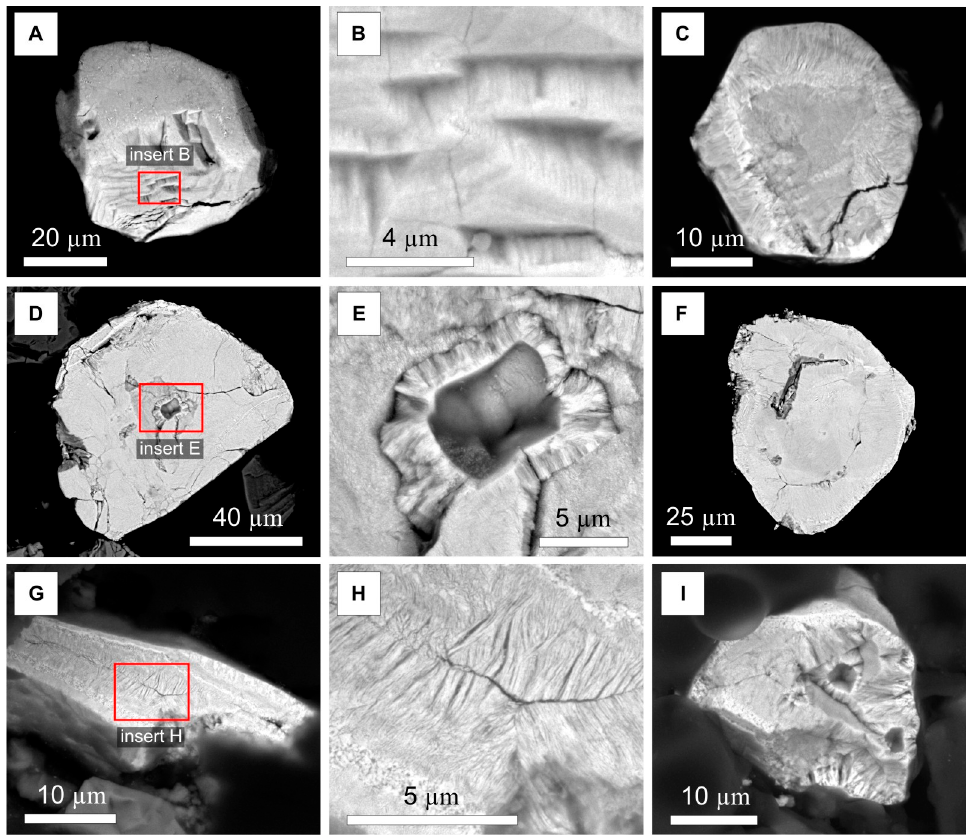
Figure 2. Back-scattered electron (BSE) images of fibrous platinum-group minerals (PGM). ( A ) fibrous PGM with an anhedral shape; note the fractured lower part of the grain revealing numerous layers of nanofiber-bundles; ( B ) close-up of nanofiber-bundles; ( C ) subhedral fibrous PGM; ( D ) anhedral fibrous PGM with a void in its central part; ( E ) close-up showing a void with radially propagating nanofiber-bundles; ( F ) anhedral fibrous PGM; ( G ) fibrous PGM with an elongated morphology; note that nanofiber-bundles have a symmetric distribution and are orthogonal to the surface of the grain; ( H ) close-up showing the central part of an elongated fibrous PGM; ( I ) anhedral fibrous PGM hosting two rounded voids.